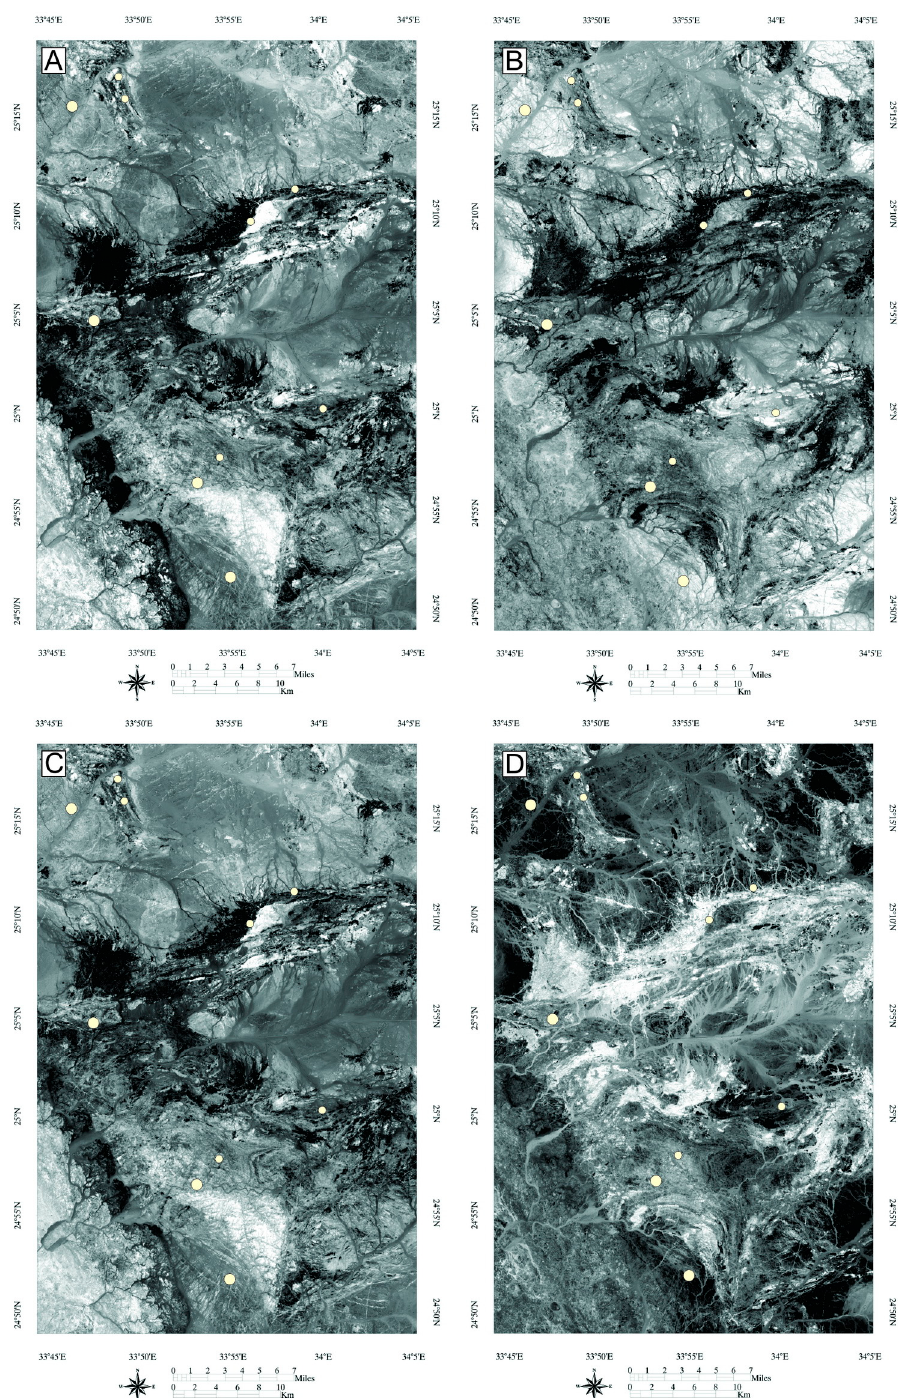
Figure 9. Band ratios of Sentinel-2 data used to map hydrothermal alteration zones in the study area: ( A ) band11 / band4 image (for gossan mapping), ( B ) band11 / band8a image (for ferric oxide-rich rocks), ( C ) band12 / band11 image (for ferrous silicate-rich rocks), and ( D ) band11 / band12 image (for hydroxyl alteration mapping).